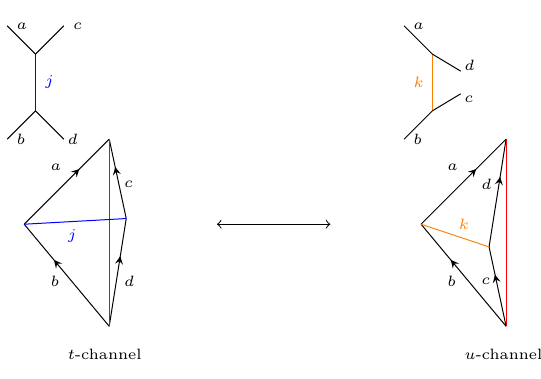
Figure 1 . Simultaneous poles connected by a type II